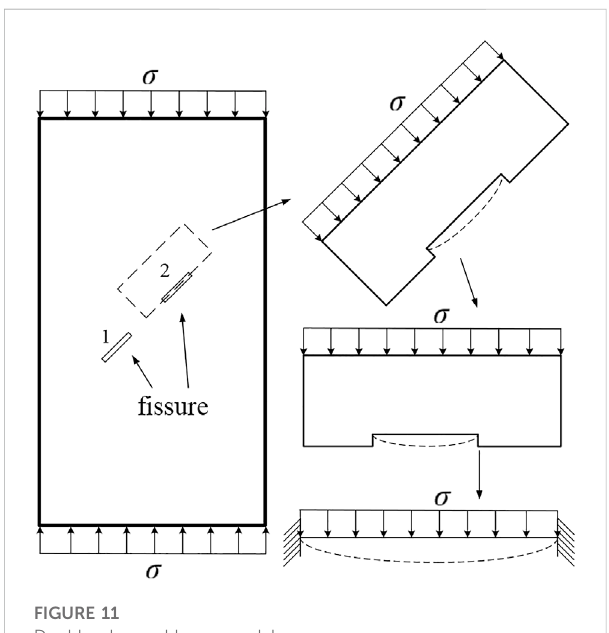
FIGURE 11 Double-clamped beam model.